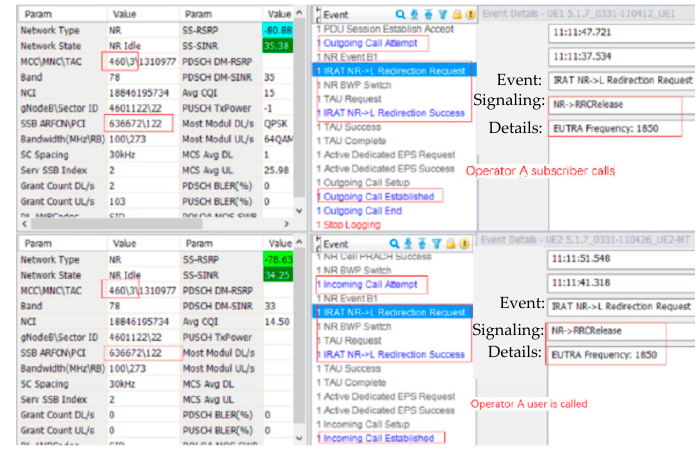
Figure 15. EPS fallback test process based on redirection.